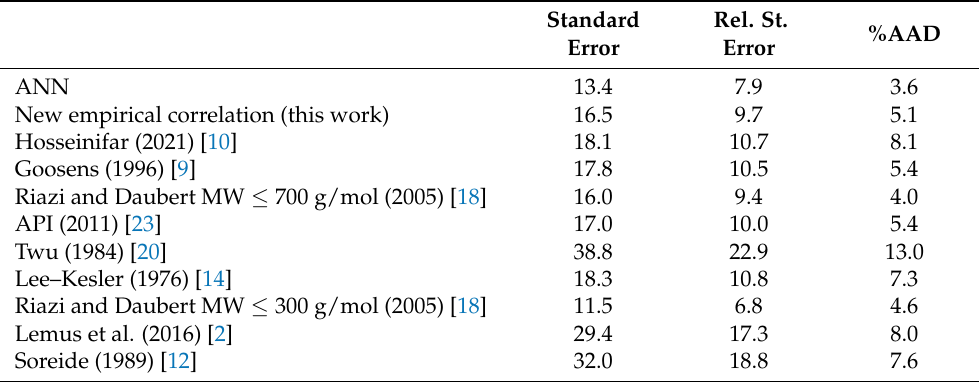
Table 3. Statistical analysis of studied methods to predict molecular weight for petroleum fluids and individual components whose molecular weight ≤ 300 g/mol.